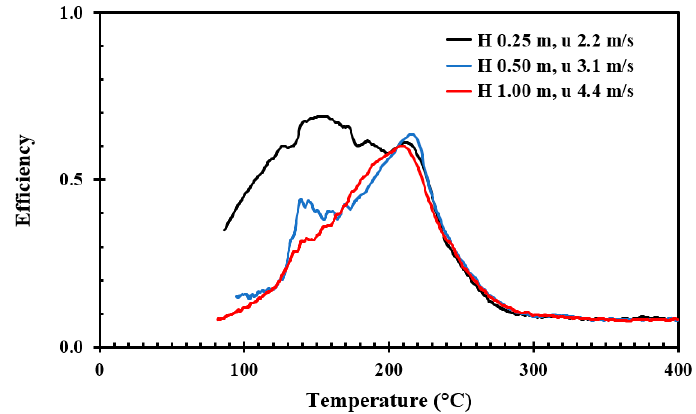
Figure 9. Cooling efficiency for pure water droplets at horizontal disc orientation, droplet diameter 2.5 mm. Impingement heights and speeds are given in the figure label.